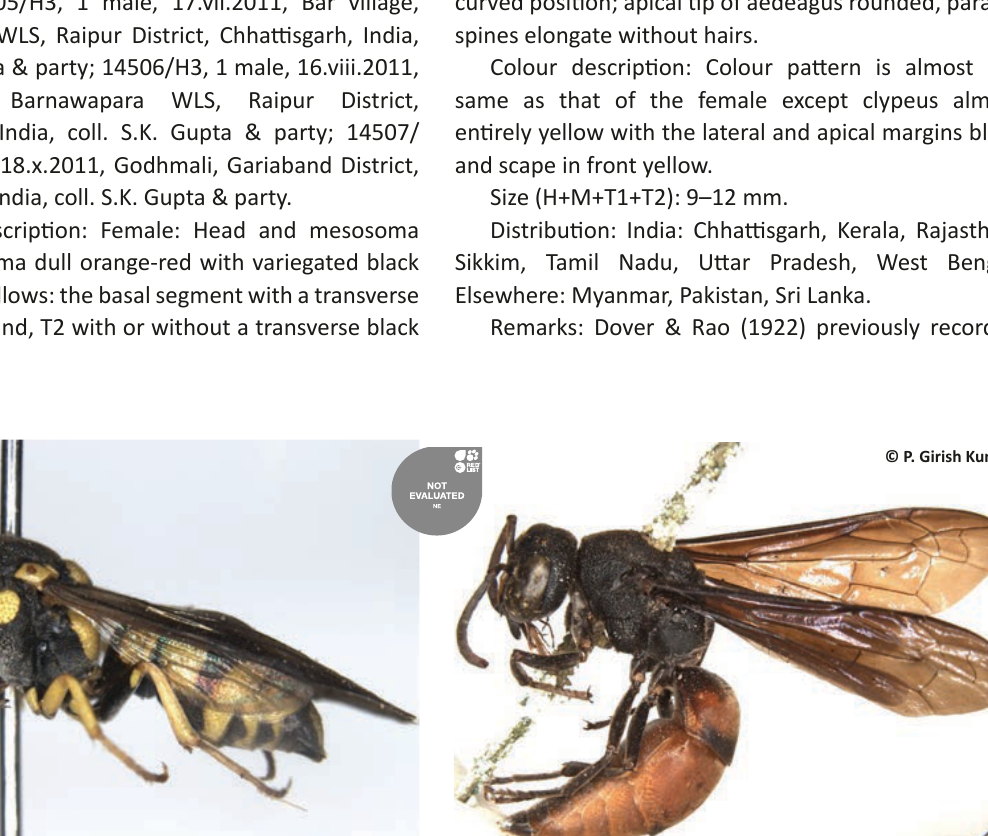
Colour description: Female: Head and mesosoma black; metasoma dull orange-red with variegated black markings as follows: the basal segment with a transverse black apical band, T2 with or without a transverse black